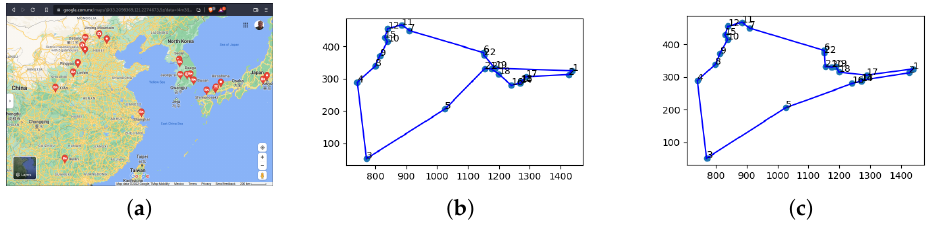
Figure 27. Map and solution of instance “ Asia.tsp ”. ( a ) Map [49]; ( b ) Solution; ( c ) Improved solution.